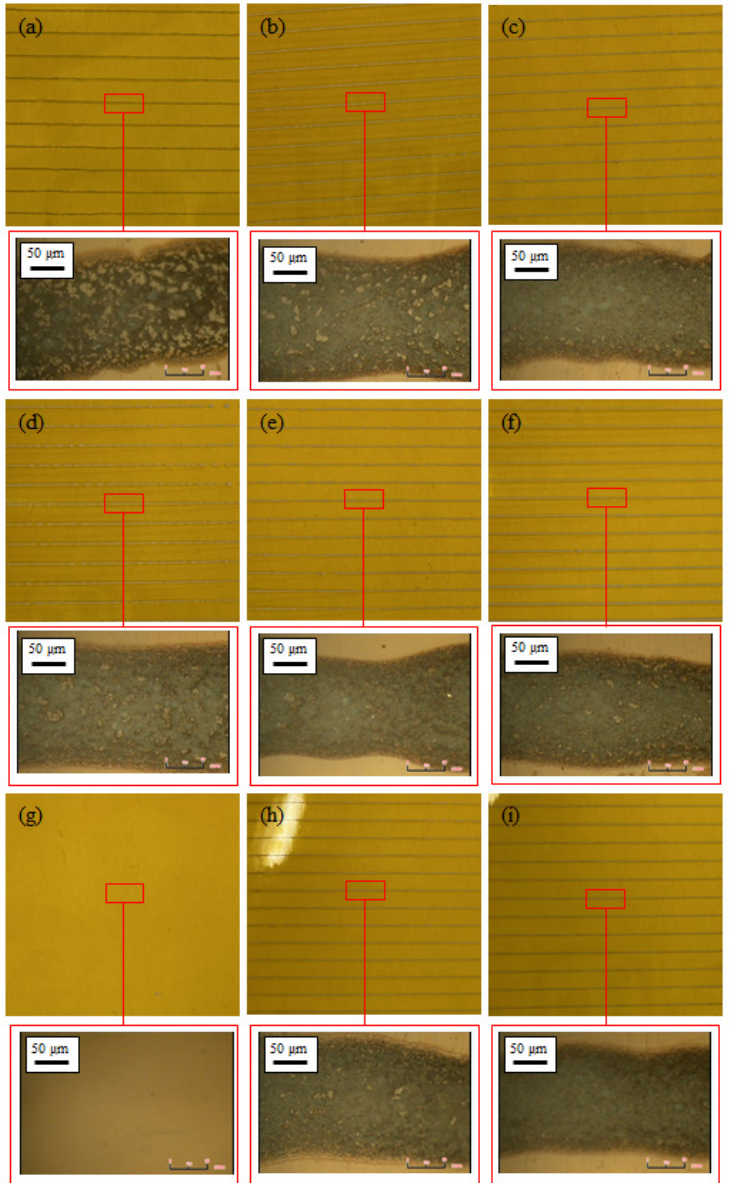
Figure 6. Ink printing results using the EHD inkjet printing and the particle density obtained using an optical microscope (magnification: 1200×): ( a ) 100:100, ( b ) 100:150, ( c ) 100:200, ( d ) 150:100, ( e ) 150:150, ( f ) 150:200, ( g ) 200:100, ( h ) 200:150, and ( i ) 200:200 (nanoceramics:silver nanoparticles).